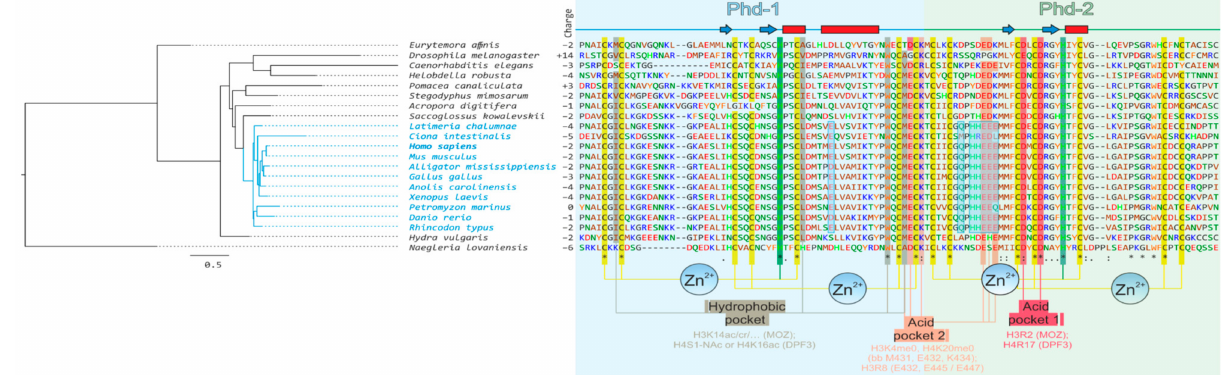
Figure 4. Amino acid alignment of PHF10 from different species and (probably) several ancestral forms. For details of the figure description, see Figure 3. Chordata in the tree are highlighted in blue . The conserved PHF10 features for this clade are in blue semi-transparent boxes